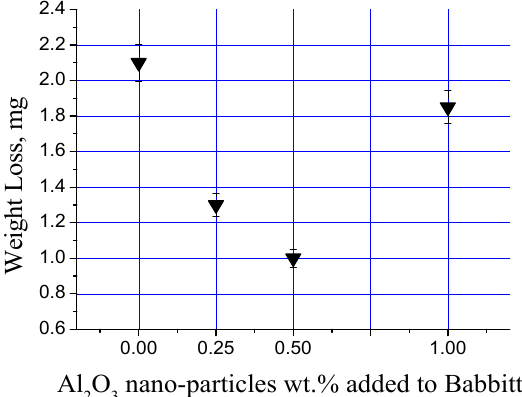
Figure 11. The average wear results of tin-based Babbitt alloy reinforced with alumina nanoparticles.